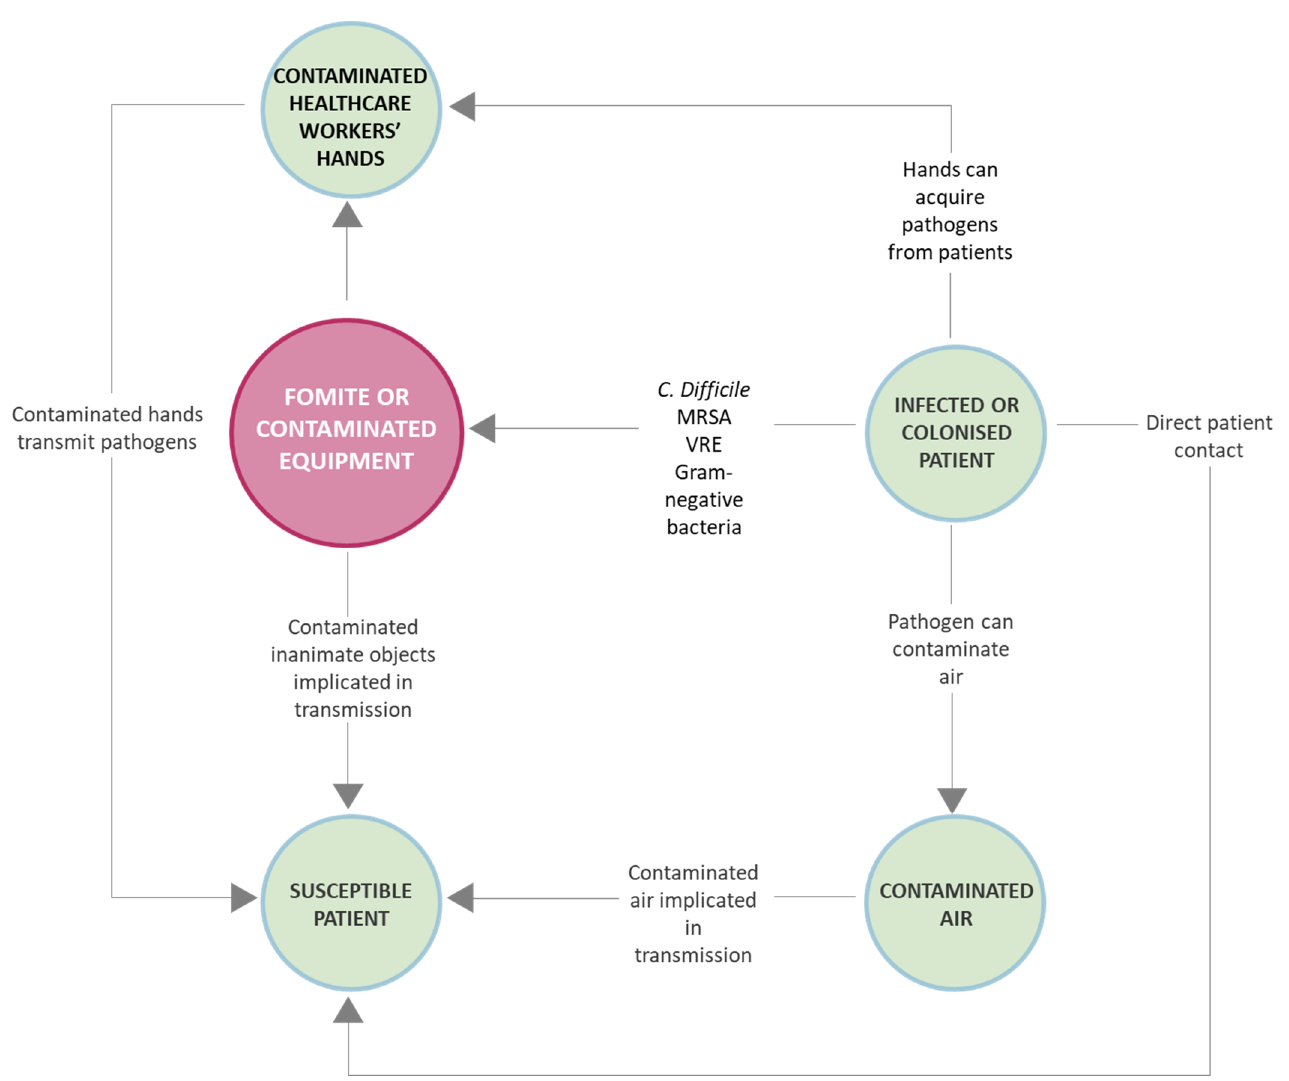
Figure 1. Generic transmission route.